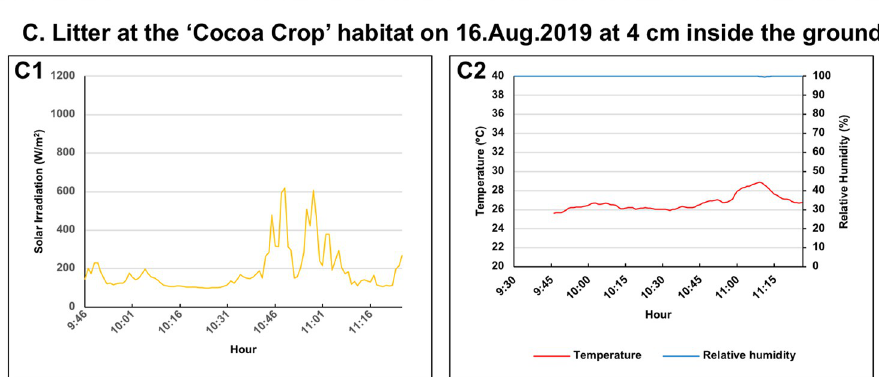
temperature has been between 21 and 33˚C for three decades (Table 6) and specifically at the Matepantano farm, between 18 and 37˚C, for the last seven years (Table 7). We found that A . mixtum achieved the maximum niche width in the dry season. In this way, we hypothesize